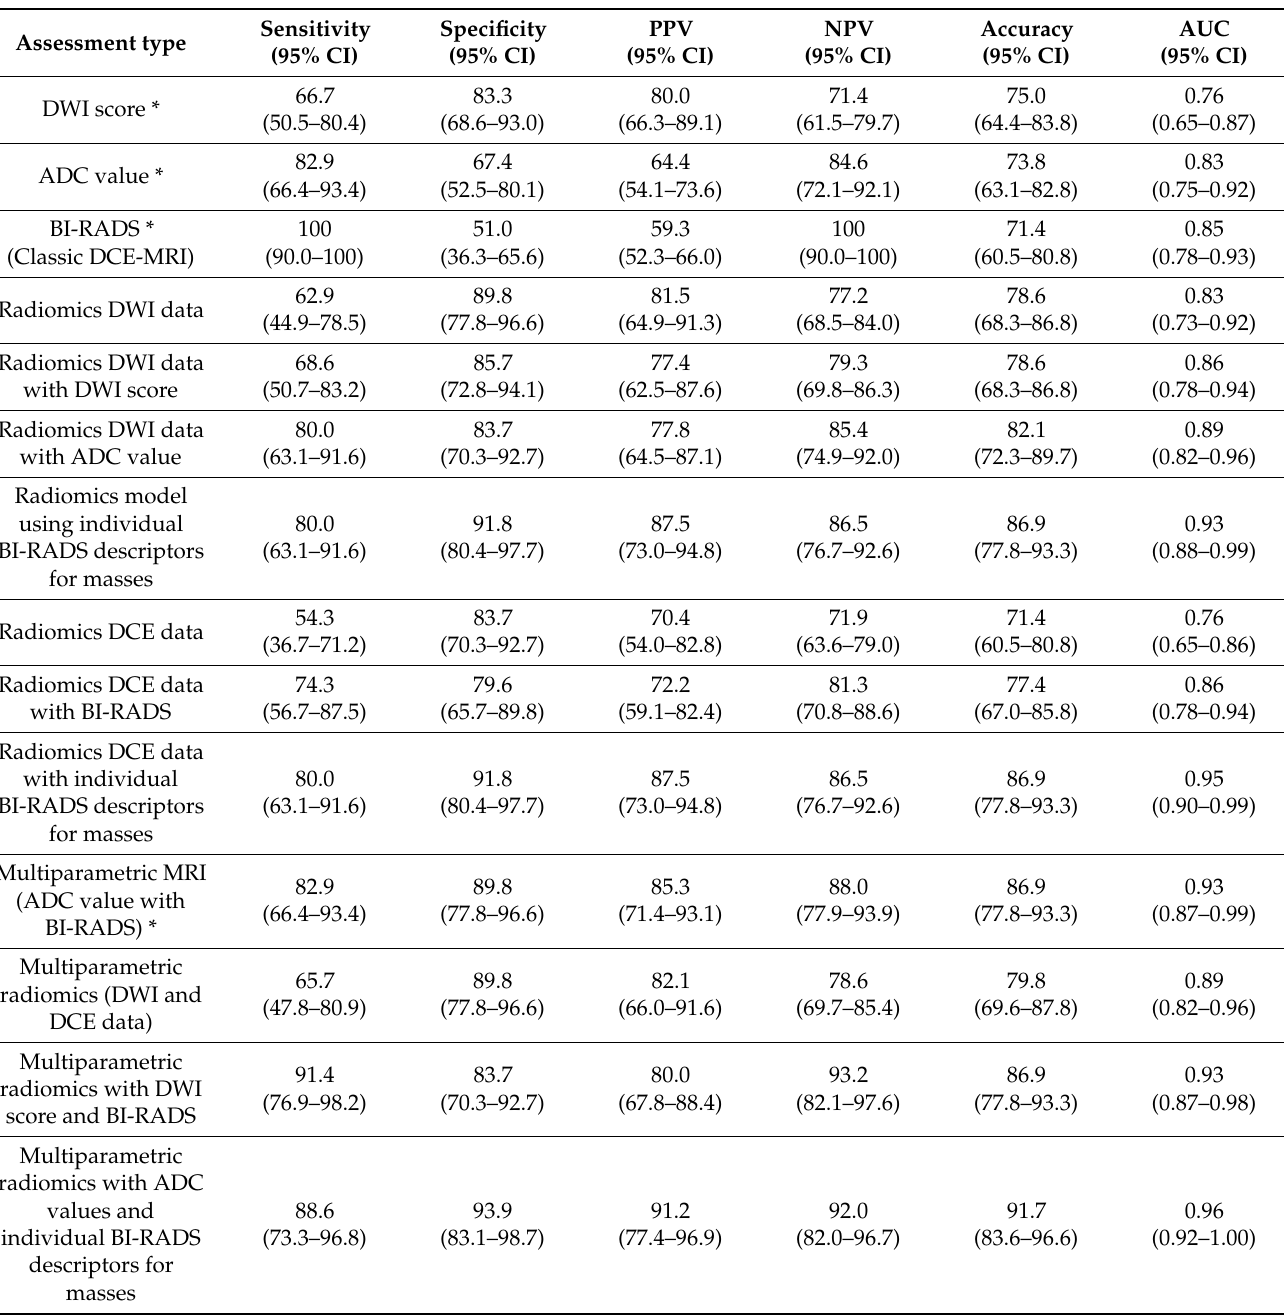
Table 4. Diagnostic metrics for the performance of radiologists * and radiomics combining different approaches for mass lesions